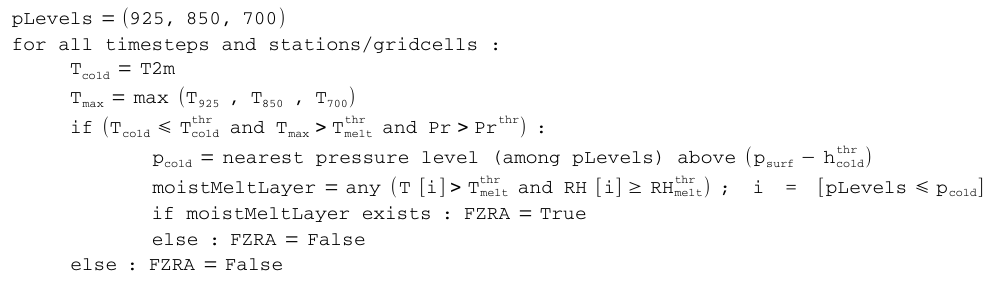
Figure 2. A pseudo-code representation of the FMI algorithm. See text for definitions of symbols and for a description of the logic.